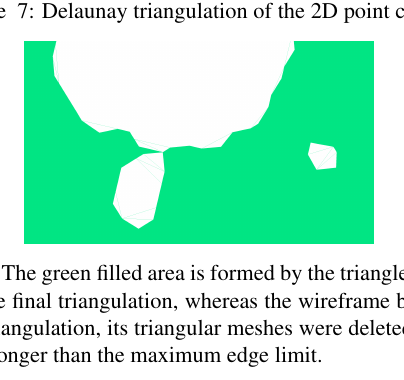
Figure 7: Delaunay triangulation of the 2D point cloud.